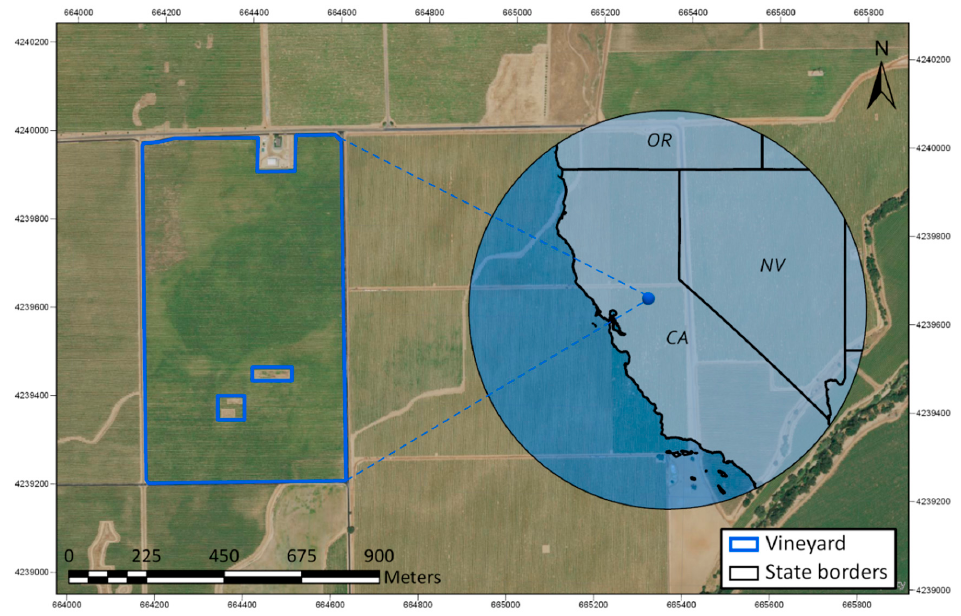
Figure 1. The vineyard study site in Central Valley, California. The vineyard management complex and vernal pools within the area of the vineyard were masked out.